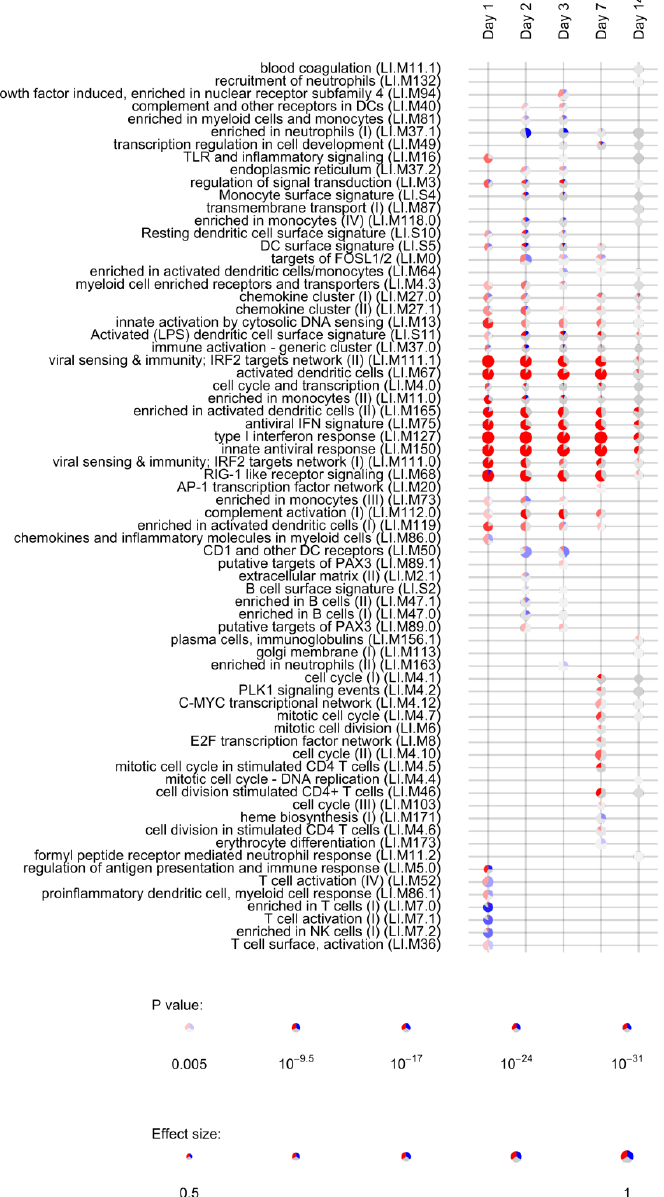
Figure 3. Activation of blood transcription modules by rVSVΔG-ZEBOV vaccination. Each column represents a study day after vaccination. Activation of modules was tested using the false discovery rate (FDR)-ranked lists of genes generated by edgeR glmTreat fitting and applying the CERNO test. Rows indicate different blood transcription modules, which were significantly (FDR < 0.005) activated in at least one time point. Each module is represented by a pie in which the proportion of significantly upregulated and downregulated genes is shown in red and blue, respectively. The grey portion of the pie represents genes that are not significantly differentially regulated. The significance of module activation is proportional to the intensity of the pie, while the effect size (Area Under the Curve) is proportional to its